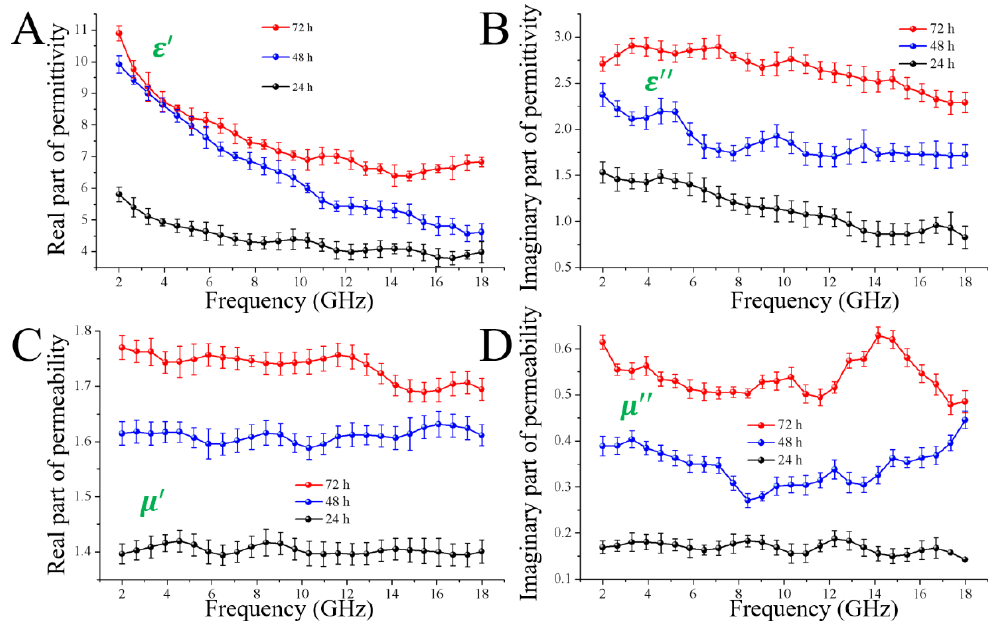
Figure 6. Frequency dependences of real parts ( A ) and imaginary parts ( B ) of complex permittivities, and the real parts ( C ) and imaginary parts ( D ) of complex permeabilities of the magnetic fiber boards with different impregnation time, 24 h, 48 h and 72 h, respectively.